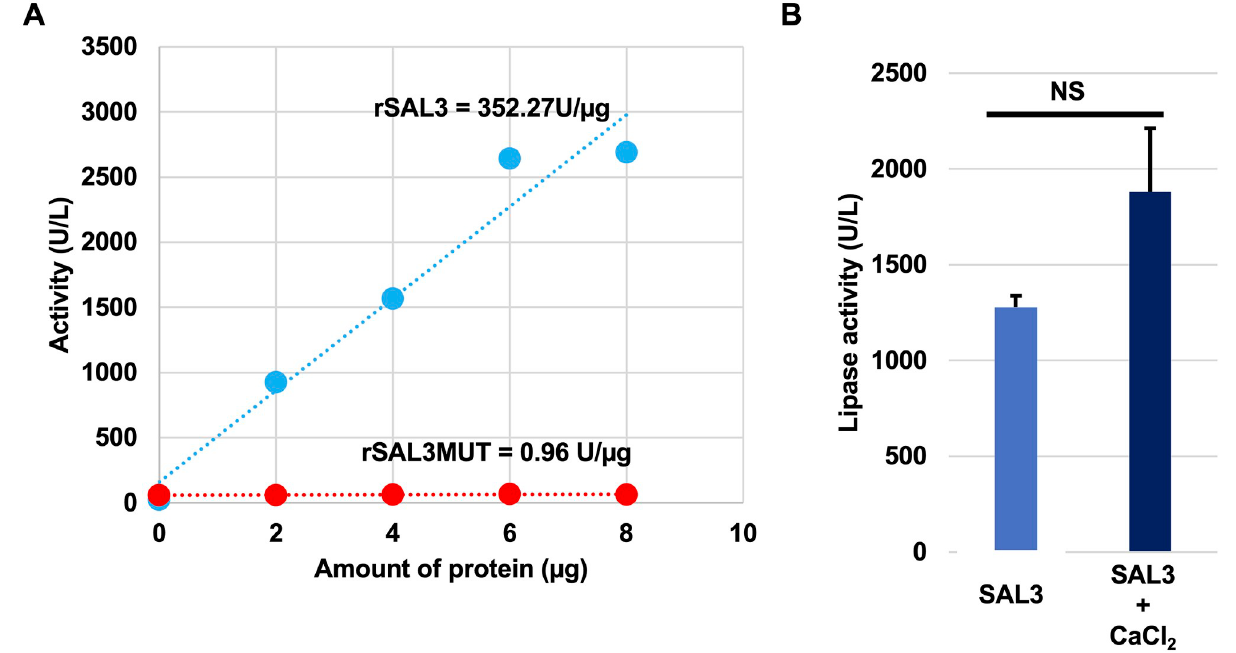
Fig 3. Lipase activity of SAL3 depends upon conserved residues but does not require calcium. A. The lipase activity of recombinant SAL3 (rSAL3) and a version of the peptide in which Ser 66 , Asp 161 , Ser 162 , and His 295 had all been converted to alanine residues (rSAL3MUT), was determined using a DTNB based lipase assay kit. B. The effect of calcium on activity of 10 μ g rSAL3/mL (0.25 μ M) was determined by removing calcium by dialysis against PBS containing EDTA and then adding 1 mM calcium back to the protein. Error bars are standard deviations of experiments done in triplicates. Significance for t-test p <